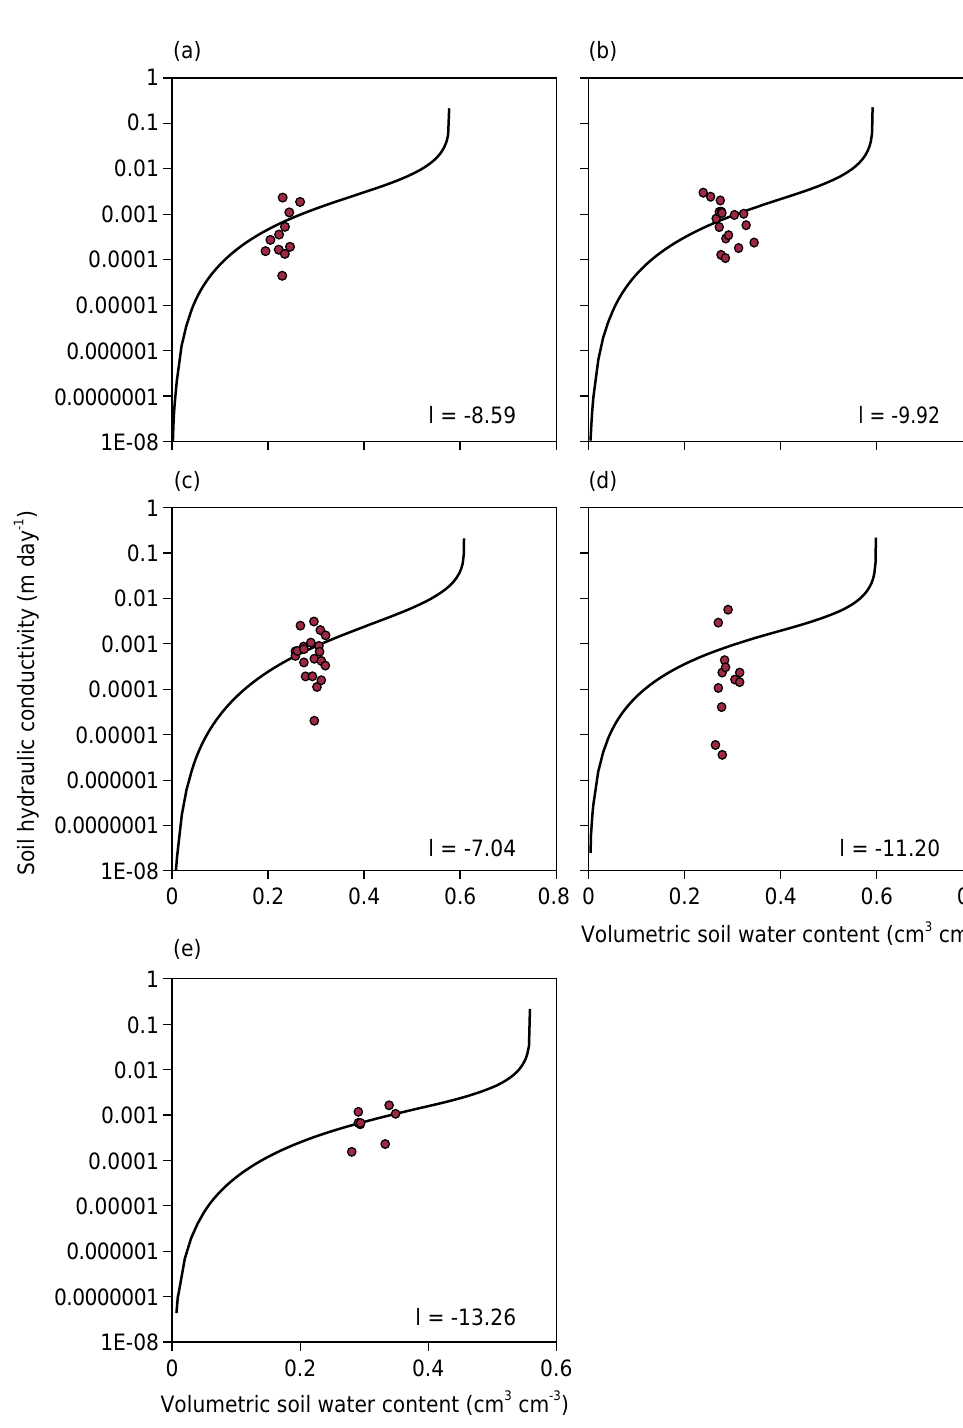
Figure 3. Comparison between the point values of soil unsaturated hydraulic conductivity ( K ), determined in this study, and the Mualem–van Genuchten K ( θ ) relationship ( l fitted) for the different soil profile depths. (a) 0.15 m depth; (b) 0.3 m depth; (c) 0.45 m depth; (d) 0.6 m depth; and (e) 0.9 m